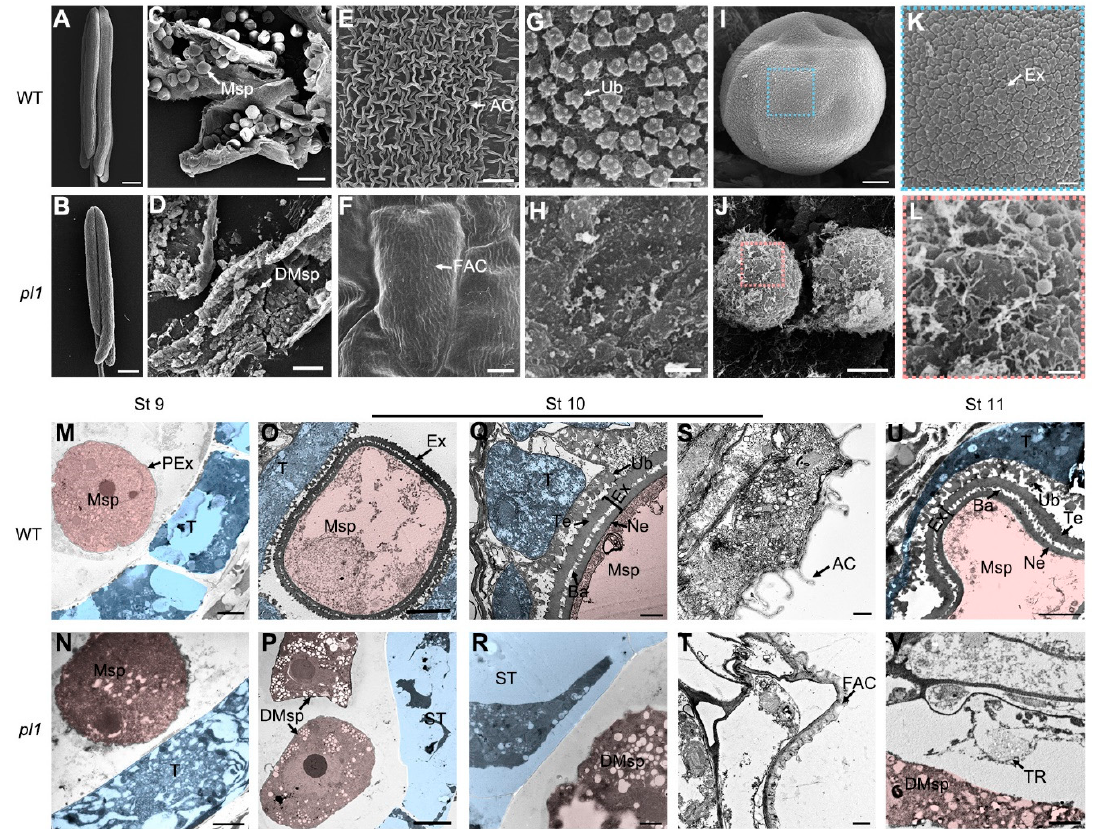
Figure 7. SEM and TEM analysis of the anthers in WT and pl1 . ( A–L ) SEM observations of the surfaces of anther and microspores at stage 10 in WT and pl1 . M-V TEM analysis of the anther sections in WT and pl1 from stages (St) 9 to 11. Microspores are false colored in orange. Tapetum is false colored in blue. A and B The appearance of entire anther of WT ( A ) and pl1 ( B ). ( C , I ) Microspores in WT anthers. ( D,J ) Microspores in pl1 anthers. ( E,F ) The outer surface of the epidermis of WT ( E ) and pl1 ( F ) anthers. ( G,H ) The inner surface of tapetum of WT ( G) and pl1 ( H ) anthers. ( K,L ) The enlarged view of the microspore surface of WT ( K ) and pl1 ( L ). ( M,N ) Tapetum and microspore at stage 9 in WT ( M ) and pl1 ( N ). ( O,P ) Tapetum and microspore at stage 10 in WT ( O ) and pl1 ( P ). ( Q,R ) Tapetal cells and pollen exine at stage 10 in WT ( Q ) and pl1 ( R ). ( S,T ) The outer region of anther epidermis at stage 10 in WT ( S ) and pl1 ( T ). ( U,V ) Tapetal cells and pollen exine at stage 11 in WT ( U ) and pl1 ( V ). AC, anther cuticle; Ba, bacula; DMsp, degrading microspores; Ex, exine; FAC, flat anther cuticle; Msp, microspores; Ne, nexine; PEx, primexine; ST, swollen tapetal cells; T, tapetum; Te, tectum; TR, tapetal remnants; Ub, Ubisch bodies. Bars = 200 µ m in ( A ) and ( B ), 50 µ m in ( C ) and ( D ), 5 µ m in ( E ), ( F ), ( I ), ( J ) and ( M – P ), and 1 µ m in ( G ), ( H ), ( K ), ( L ) and ( Q – V).